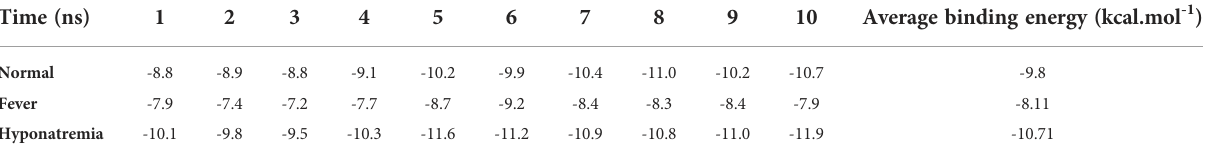
TABLE 4 Binding analysis for molecular dynamics study of Fas/FasL. Time